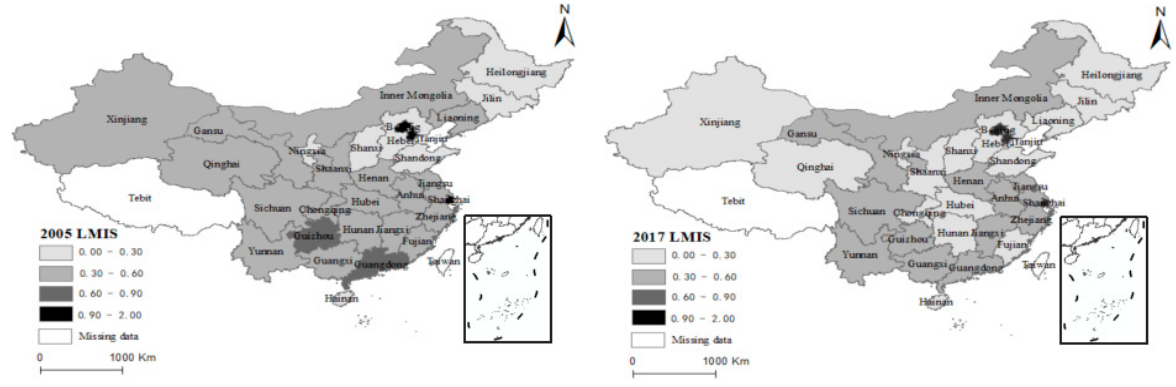
Figure 3. Spatial layout of LMIS.